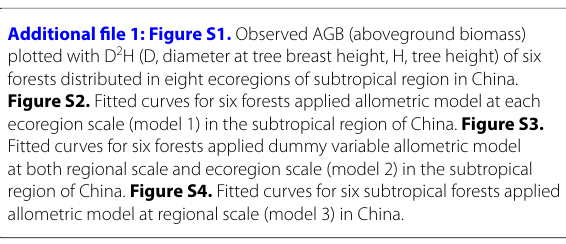
Additional file 1: Figure S1. Observed AGB (aboveground biomass) plotted with D 2 H (D, diameter at tree breast height, H, tree height) of six forests distributed in eight ecoregions of subtropical region in China. Figure S2. Fitted curves for six forests applied allometric model at each ecoregion scale (model 1) in the subtropical region of China. Figure S3. Fitted curves for six forests applied dummy variable allometric model at both regional scale and ecoregion scale (model 2) in the subtropical region of China. Figure S4. Fitted curves for six subtropical forests applied allometric model at regional scale (model 3) in China.